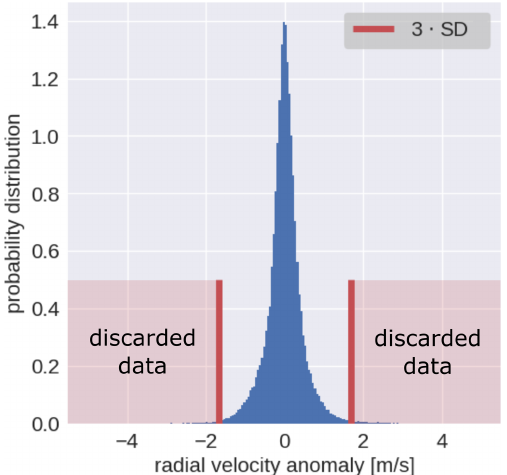
Figure 5. Example of the probability distribution of the MDV anomalies calculated using observations at azimuth equal to 0 ◦ (the same data from Fig. 4a). The vertical red lines indicate the size of the window used for filtering the data, and the light red areas indi- cate the values